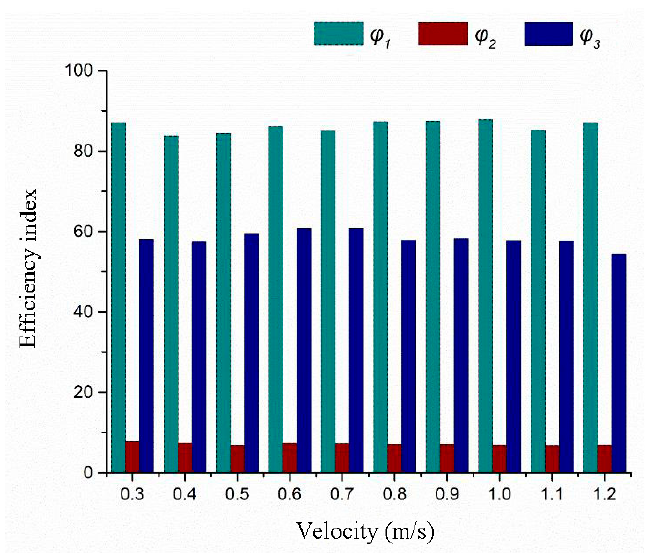
Figure 17. The efficiency indices of the optimal UR.